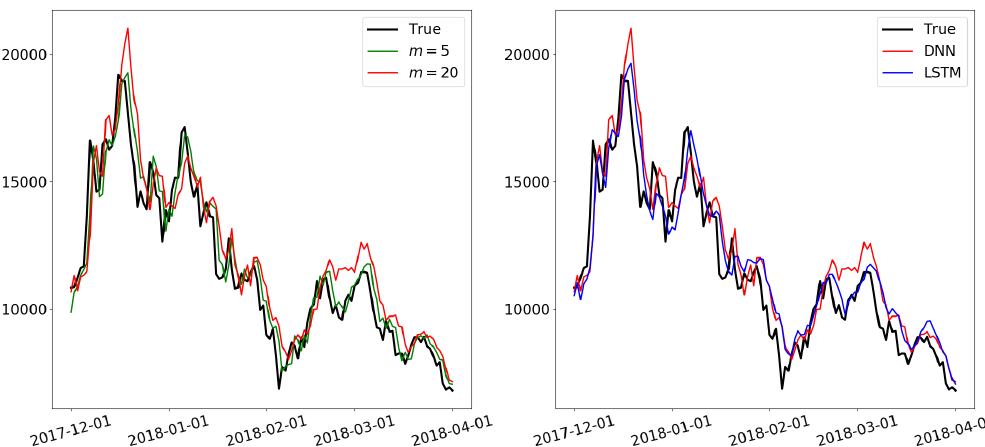
Figure 13. Prediction results of DNN with m = 5,20 ( left ) and prediction results of DNN and LSTM with m = 20 ( right ) from 1 December 2017 to 1 April 2018, excerpted from Figures 11 and